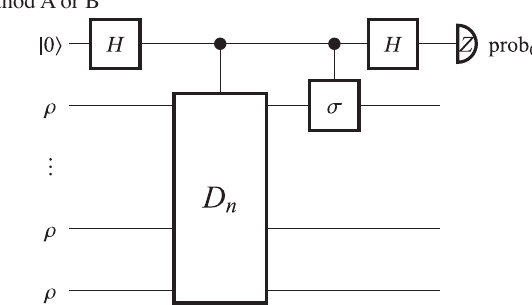
FIG. 1. A possible implementation of the ESD approach. Our derangement operator D n is a generalization of the SWAP operator and acts on n (not necessarily identical) copies of the quantum state ρ ¼ λ j ψ ih ψ j þ ð 1 − λ Þ ρ . In the above circuit D n permutes err the n registers and allows only permutation symmetric combi- nations, e.g., j ψ i ⊗ n , to contribute to the expectation-value measurement process. The probability of measuring the ancilla qubit in the 0 state enables us to approximate the expectation value h ψ j σ j ψ i and errors are suppressed exponentially in n . This derangement operator can be implemented as a shallow circuit using a linear number N ð n − 1 Þ of primitive, controlled, 2-qubit SWAP